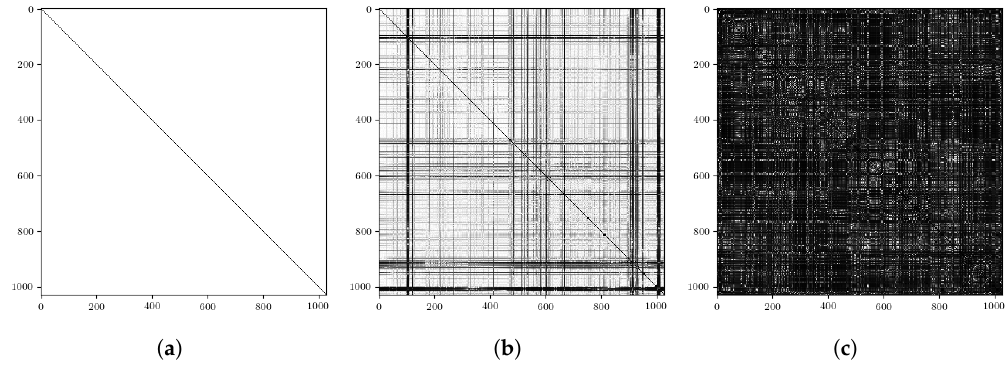
Figure 4. Examples of pairwise compatibility matrices, C , which as described in more detail in Section 3.2 are used to solve for the SE ( 2 ) motion of the sensor. ( a ) A trivial example arising from the same radar scan passed to the pose refinement module. ( b ) An example using two radar scans in close proximity but with some offset. ( c ) An example where two radar scans are taken from distant locations in the world. From these, it is clear that the “brightness” of the (visualised) compatibility matrix can be used as a quality-score measure for the metric localisation solution as described in Section 4. Importantly, the dimensions of these matrices are determined by the number of matching landmarks between the two input radar scans (after data association). Examples of these landmark sets are shown in Figure 3, where in Figure 4b C is of shape 1029 × 1029 corresponding to W = 1029 of the | L 1 | = 1029 orange and W = 1250 of the | L 2 | = 1074 blue landmarks in Figure 3a.